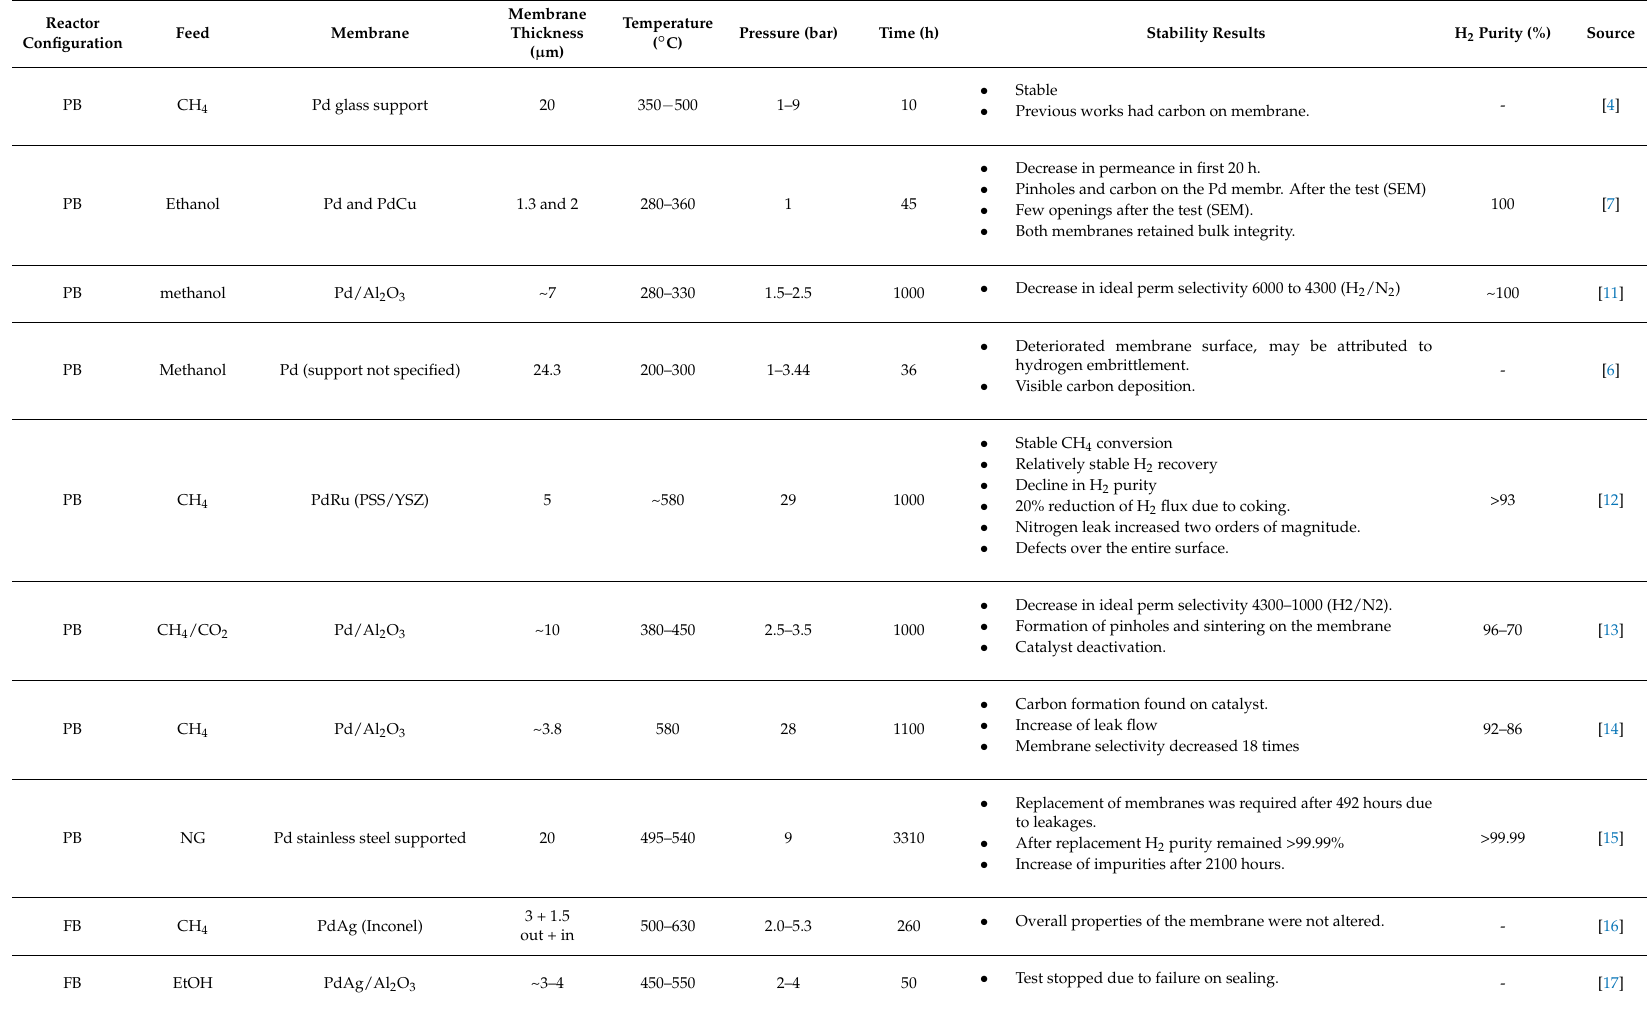
Table 1. Stability results in literature for membrane